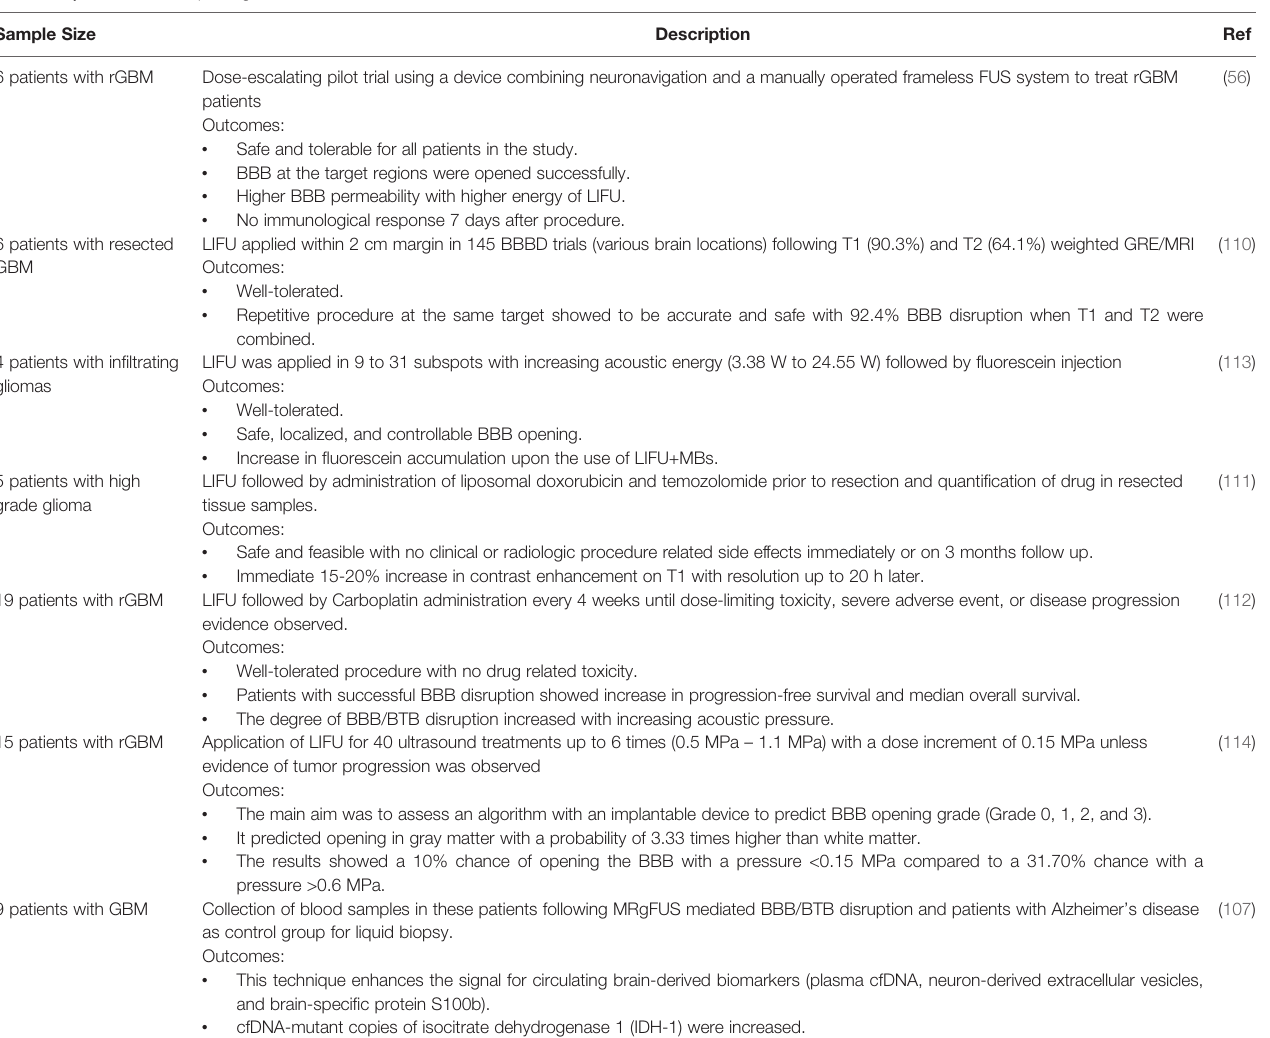
TABLE 7 | Clinical trials exploiting